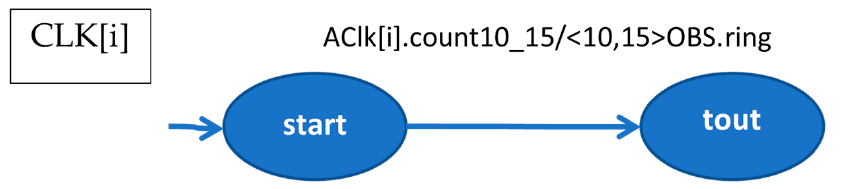
Figure 10. The automaton modeling an ith clock, CLK [i].